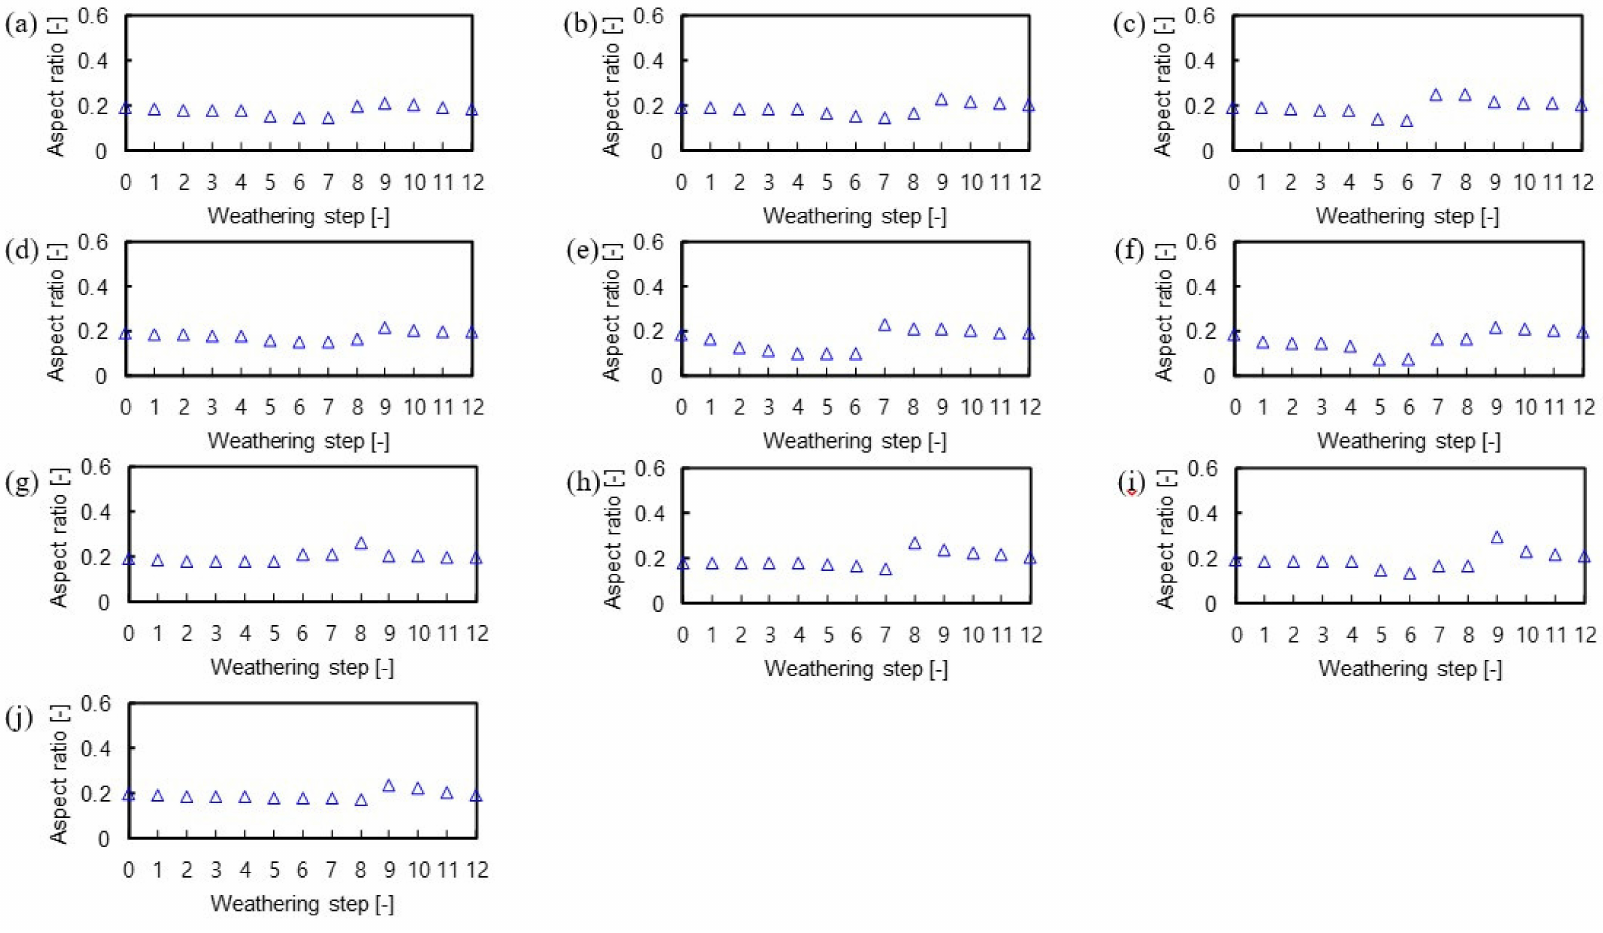
Figure 8. Distributions of aspect ratio for each sample: ( a ) albite 1, ( b ) albite 2, ( c ) albite 3, ( d ) albite 4, ( e ) quartz 1, ( f ) quartz 2, ( g ) quartz 3, ( h ) biotite, ( i ) calcite, and ( j )